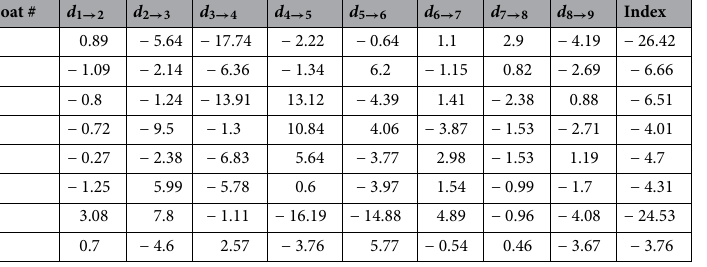
Table 3. Daily scores and global index for goats’ response to high-concentrate diet challenge. d i → i + 1 is the value assigned to the quality of the response of each goat from day d i to d i + 1 for i ∈ { 1, .., 8 } . Decreasing values of A from day d i to d i + 1 are associated with the capacity to adapt to the new diet, which is recognised with a positive daily score. Conversely, increasing values of A from day d i to d i + 1 show that goats had difficulties adapting to the new diet, and negative daily scores are assigned. The value of the score depends on the variation of v 0 from day d i to d i + 1 and also the weighting ω j associated with the relative Euclidian distance between d i and d i + 1